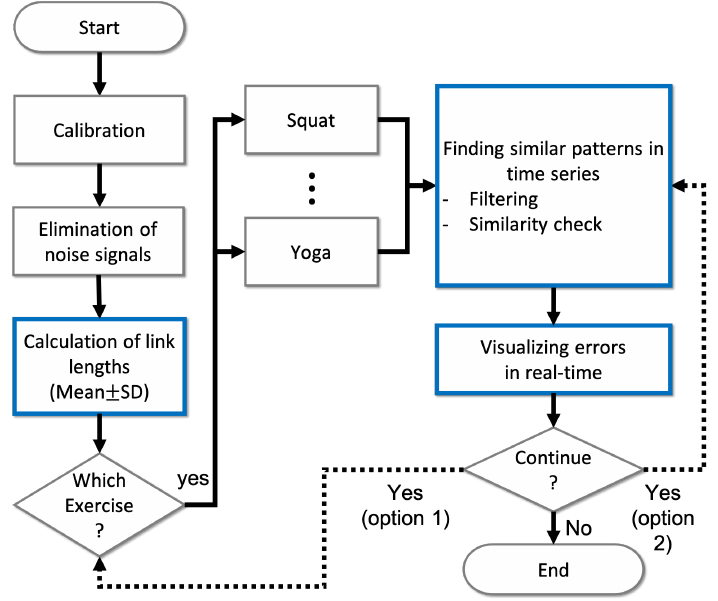
Figure 10. A flowchart to explain how to process the image acquired from the RGB camera and then to verify the similarity in exercise activities between experts and